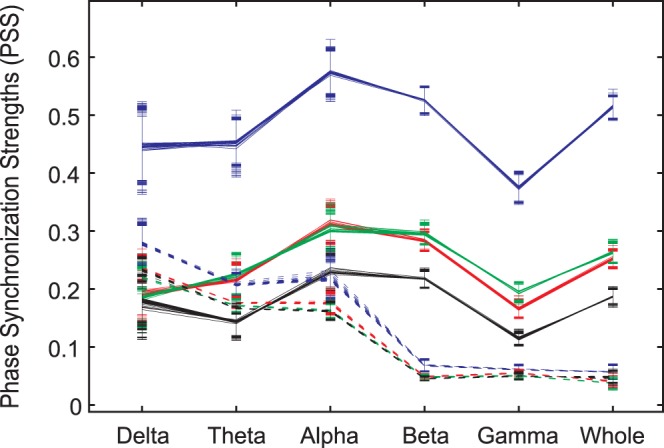
The effects of EEG reference, data length and frequency band on genuine and spurious phase synchronization strength (PSS).Each symbol denotes the mean genuine PSS (solid lines) or the mean spurious PSS (dotted lines) for the combination of data length, type of EEG reference and frequency band. The EEG reference mainly affects genuine PSS. Each color denotes a type of EEG reference (blue: unipolar reference (A2); green: longitudinal bipolar; red: common averaged reference; and black: transverse bipolar). The unipolar reference has the largest genuine PSS over all frequency bands. By contrast, the frequency band mainly influences spurious PSS. Lower frequency bands have larger spurious PSS over all types of EEG references. The error bars denote the standard deviations over the EEG data sets for 27 data lengths (from 5 to 60 seconds, with 2 second intervals). Six frequency bands were studied: delta band (0.5–4 Hz), theta band (4–8 Hz), alpha band (8–13 Hz), beta band (13–25 Hz), gamma band (25–55 Hz) and whole band (0.5–55 Hz).